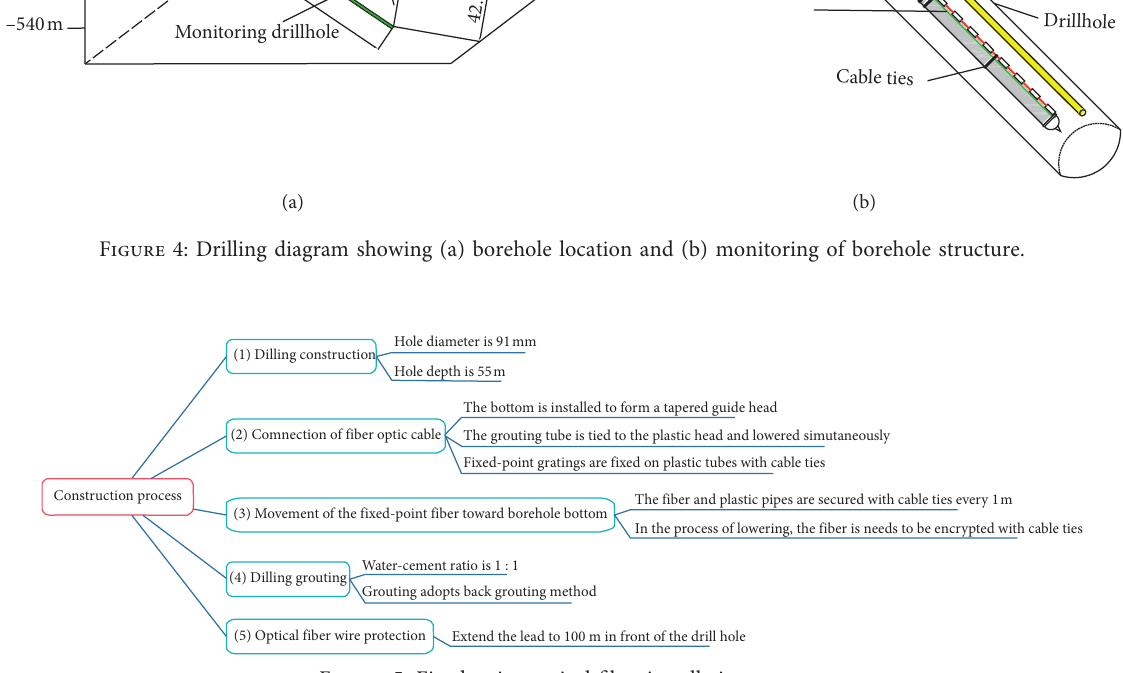
Figure 5: Fixed-point optical fiber installation steps.